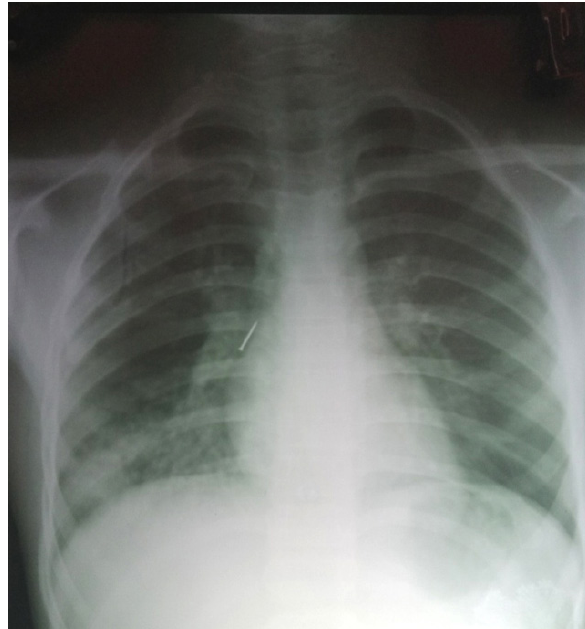
Figure 1: Chest x-ray (PA view) showing a linear hyperlucent opacity in the right pericardiac region along the course of right bronchus and right lower zone consolidation Flexible bronchoscopy was done via an oral route under deep sedation with intravenous midazolam, fentanyl, and propofol.